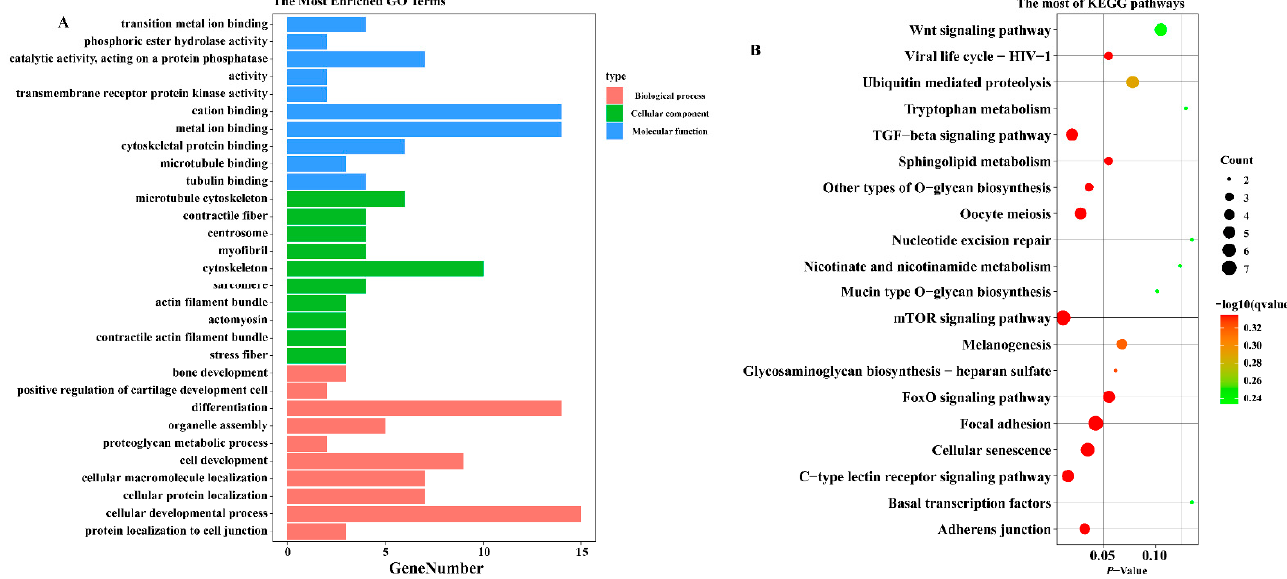
Figure 3. GO and KEGG functional enrichment analysis of source genes of DE-circRNAs. ( A ) The y -axis is the GO term at the next level of the three GO categories, and the x -axis is the number of source genes annotated for that term. ( B ) The y -axis indicates the pathway name, the x -axis indicates the p -value, the size of the dots indicates the number of source genes in the pathway, and the color of the dots corresponds to the different − log10 (qvalue) ranges.